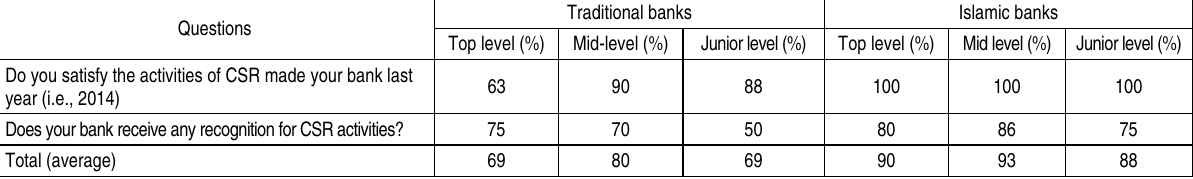
Table 5. A comparative analysis of traditional and Islamic banks management satisfaction on